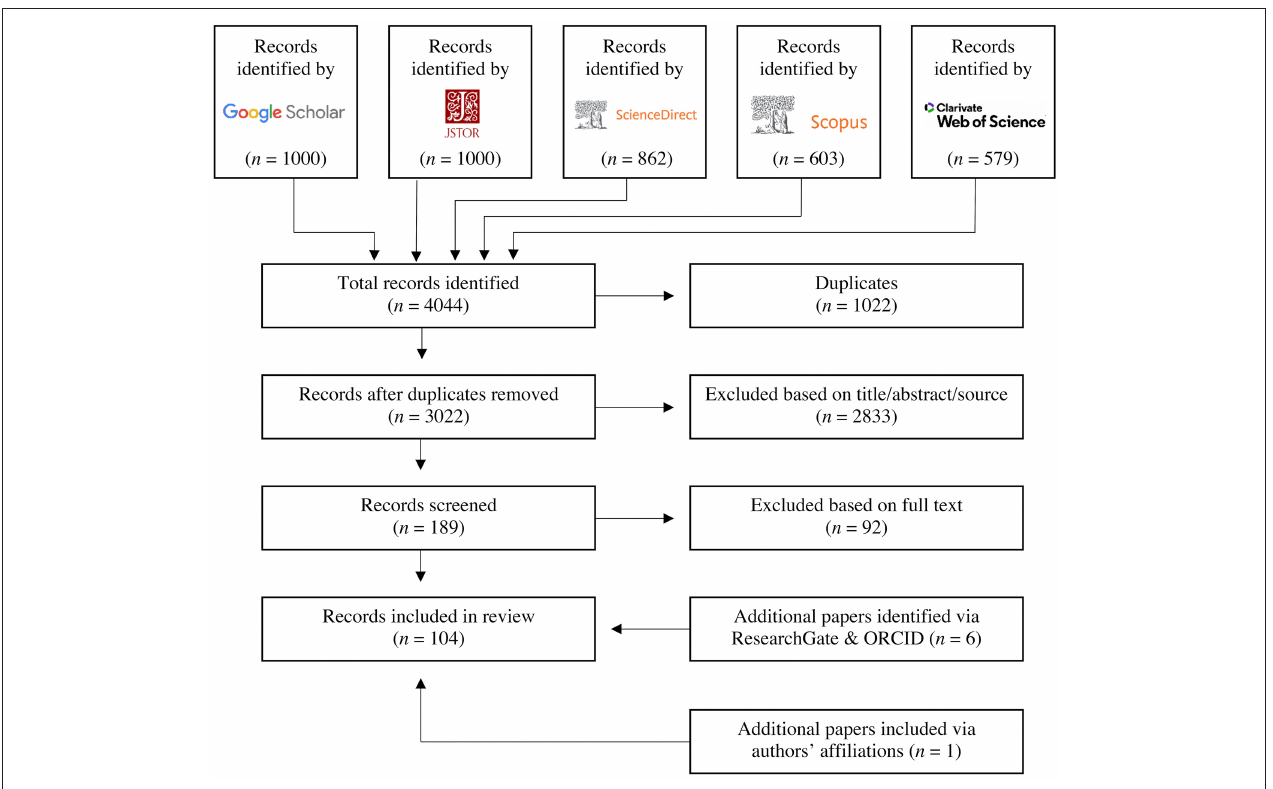
FIGURE 1 | Process for identifying and excluding records based on PRISMA guidelines